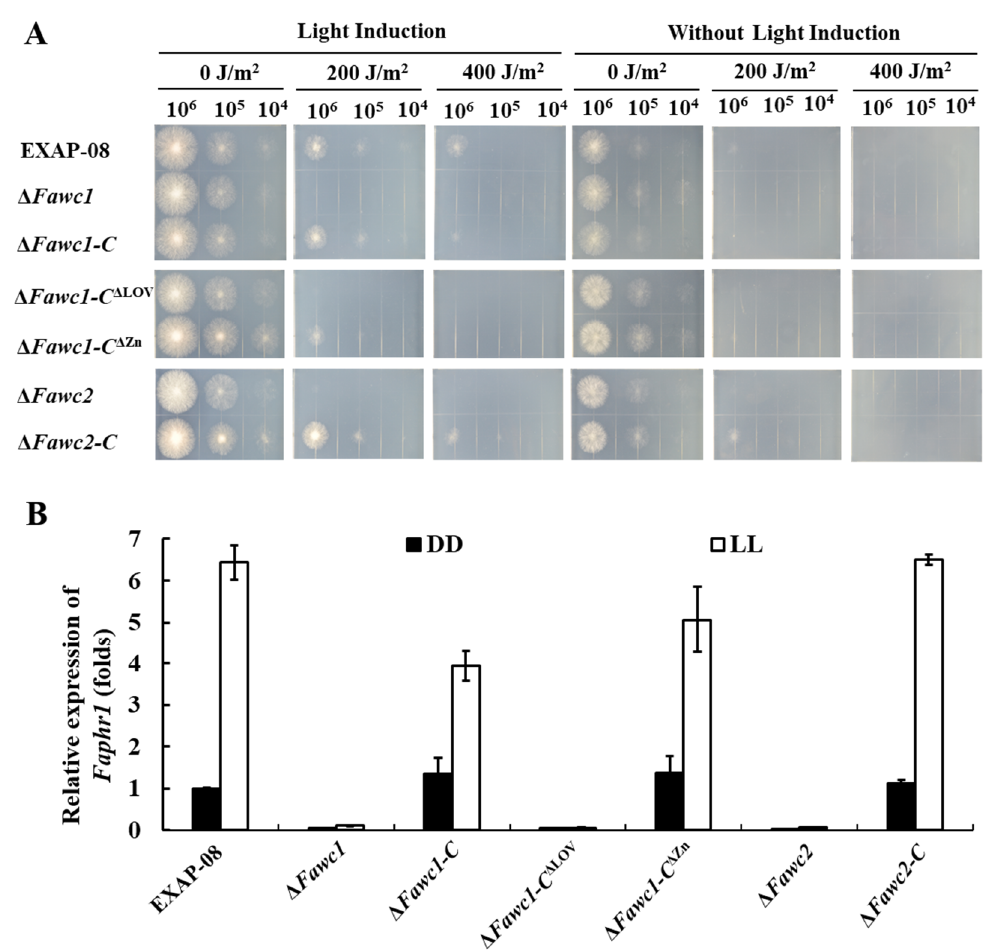
Figure 3. Effect of light on UV-C resistance. ( A ). Serial dilutions of all strains were point-inoculated onto complete agar medium (CM). After the UV irradiation of indicated dosages, the plates were incubated for one day in light (left) or darkness (right). ( B ). The relative expression level of the deduced photolyase gene Faphr1 in wild-type and mutant strains as influenced by light. DD, samples cultured for 48 h in darkness; LL, samples experienced 47 h culture in darkness followed by one hour of light illumination. The bars present mean values ± SD of three replicate samples.